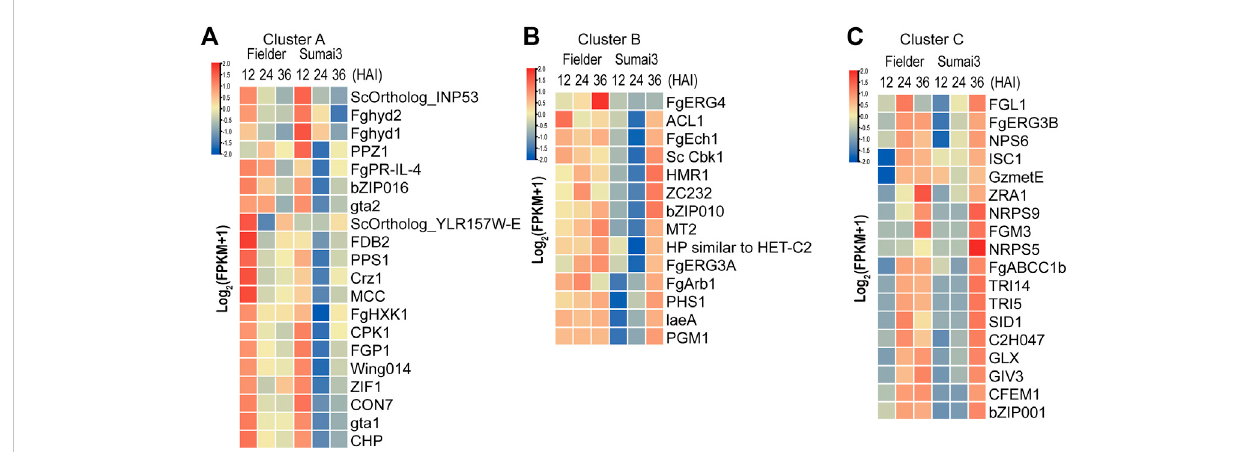
FIGURE 5 Identi fi cation of DEGs related to virulence and pathogenicity in PHI-base. (A) DEGs that exhibited high transcript abundance at 12 HAI and continuously decreased transcript abundance over the time course of infection. (B) DEGs that exhibited high transcript abundance at three timepoints after infection in Fielder, but did not exhibit high transcript abundance until 36 HAI in Sumai3. (C) DEGs that exhibited low transcript abundance at 12 HAI in both varieties and whose transcript abundance continuously increased over the time course of infection.